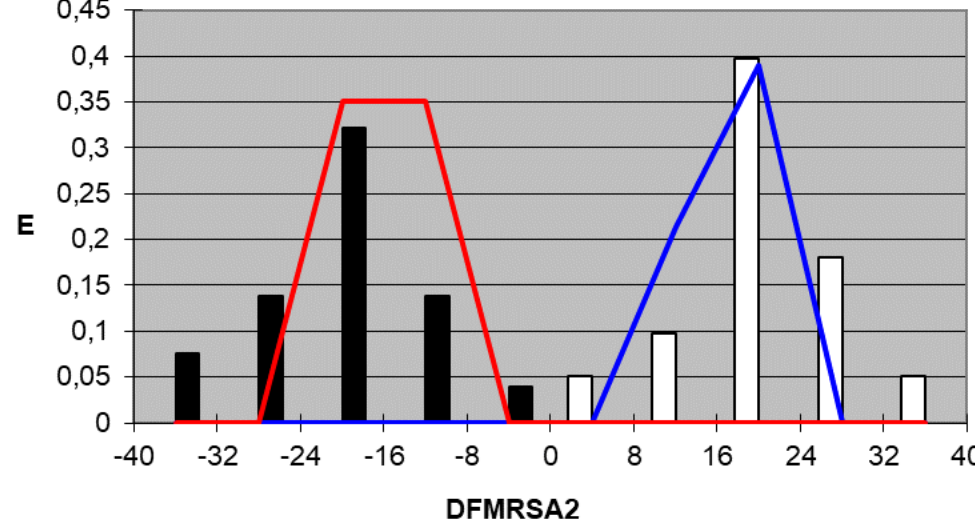
Figure 3. DF MRSA2 pharmacological distribution diagram. Black bars: Training Inactives. White bars: Training Actives. Red curves: Test Inactives. Blue curves: Test Actives.